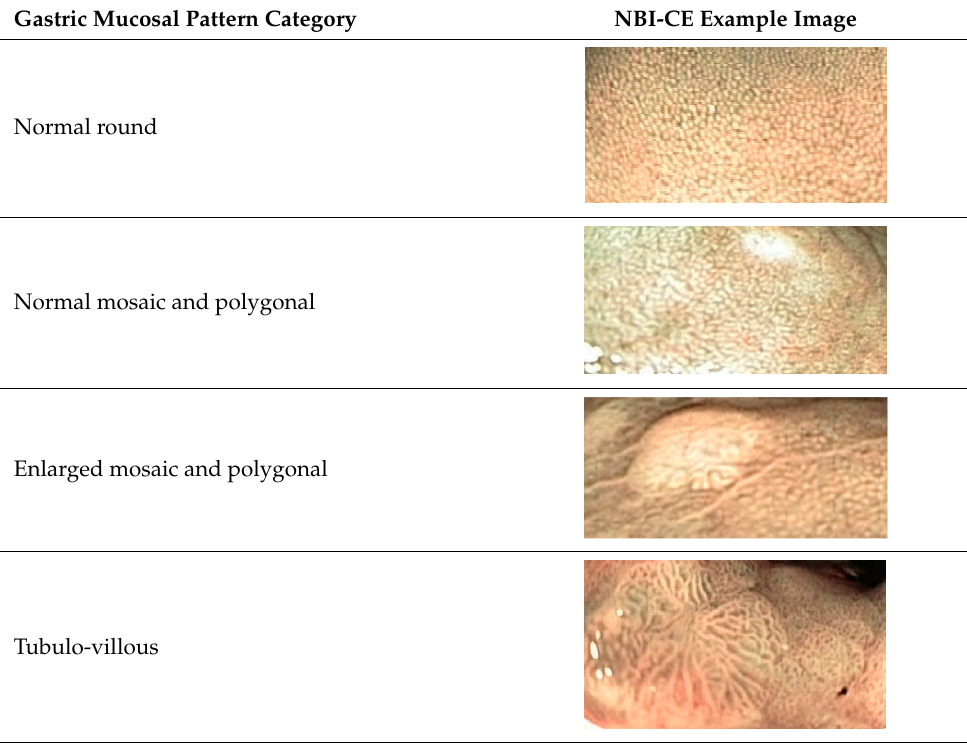
Table 1. Examples of mucosal pattern categories recognized in narrow band imaging chromoendos- copy (NBI-CE) of the gastric mucosa of dogs.